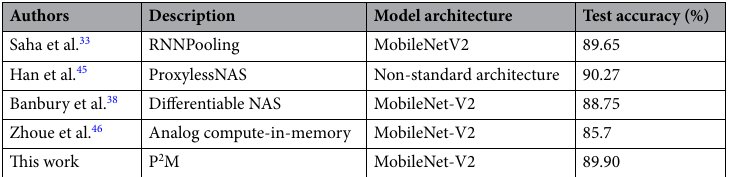
Table 3. Performance comparison of the proposed P 2 M-compatible models with state-of-the-art deep CNNs on VWW dataset.